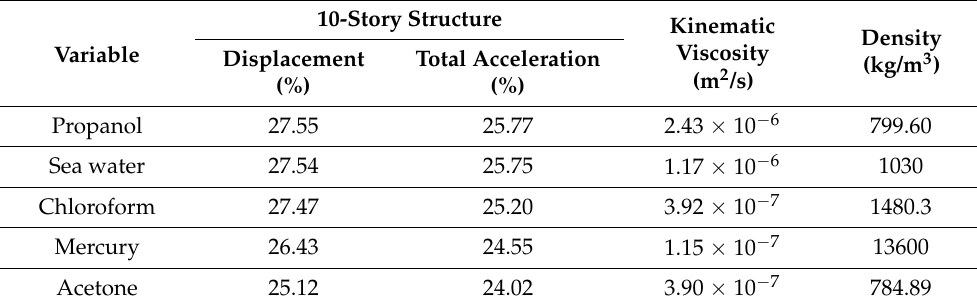
Table 12. Structure displacement and total acceleration reduction percentages with TLD for the 10-story